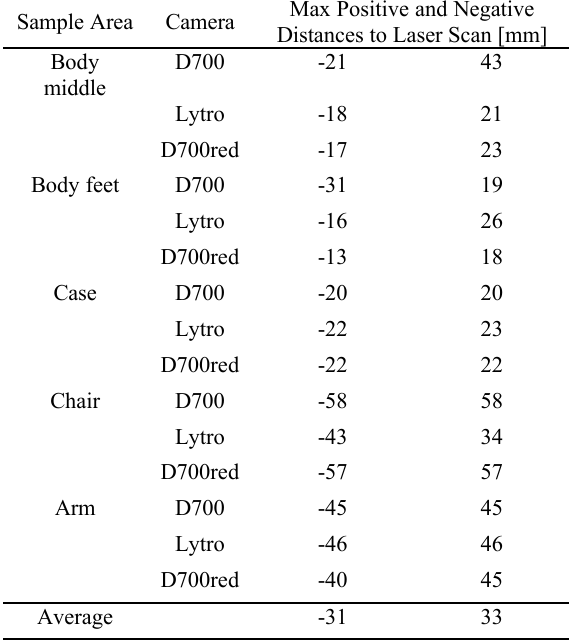
Table 4. Rough sample areas with positive and negative distance to laser scan